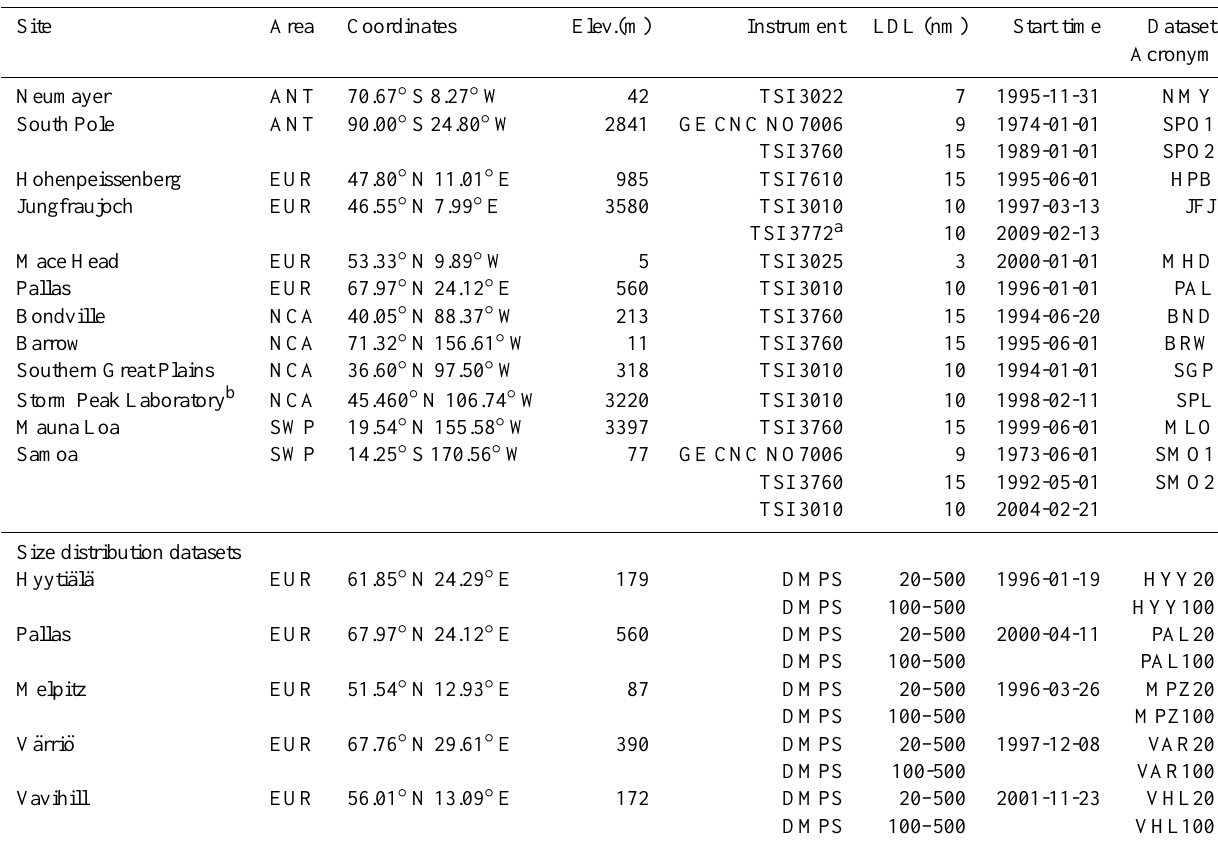
Table 1. Measurement sites and instrumentation used in the trend analysis. The lower detection limit in particle diameter (LDL) is indicated as a nominal value from the instrument manufacturer (Liu and Kim (1977) for GE CNC NO7006), and the particle range used for the size distribution measurements. The start times of each measurement are given in ISO 8601 format (YYYY-MM-DD). Last column lists the dataset